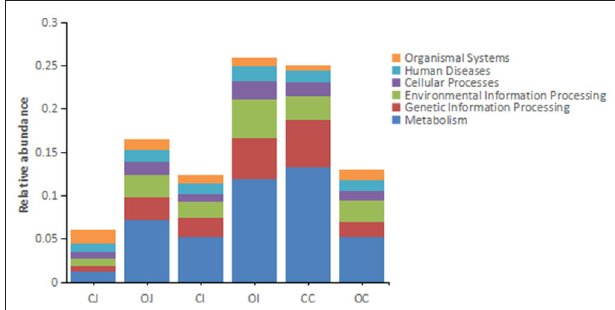
FIGURE 3 | The histograms showing the relative abundance of each annotated function of different intestinal tracts at the first tier based on KEGG pathway analysis. Note: “CJ” and “OJ” denote the jejunal tracts of the control group and the overfeeding group, respectively. “CI” and “OI” denote the ileal tracts of the control group and the overfeeding group, respectively. “CC” and “OC” denote the cecal tracts of the control group and the overfeeding group,